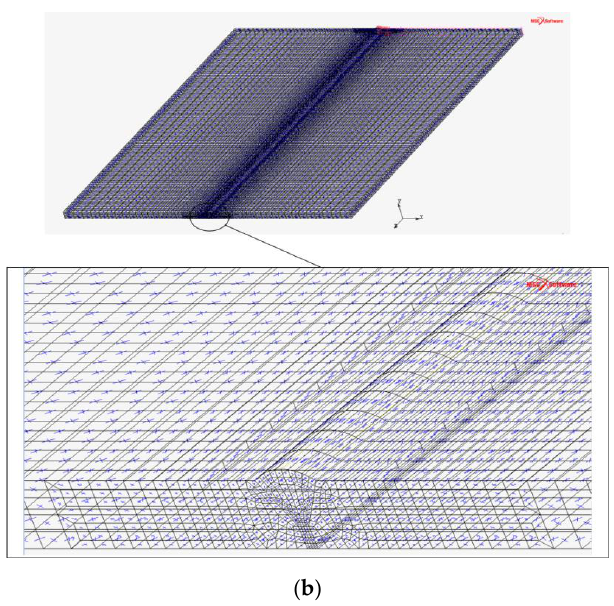
Figure 3. Meshes of the FEM: ( a ) partial magnification of grid density; ( b ) grid setup for the test piece.